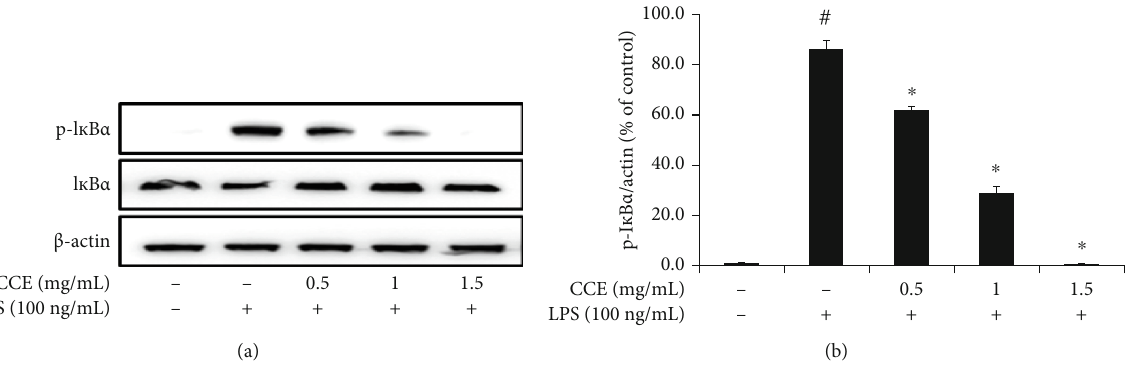
Figure 6: Commelina communis extract (CCE) treatment suppresses I κ B α phosphorylation. Murine macrophages were treated with CCE for 4h and then exposed to lipopolysaccharide (LPS) for 1h. The expression of both phospho- (p-) and total I κ B α in the cytosolic protein fraction was evaluated using western blotting (a) and quantitated using the relative expression of β -actin (b). Data are shown as the mean ± standard deviation from three independent experiments. # P < 0 : 05 compared with the control; ∗ P < 0 : 05 compared with the LPS- exposed